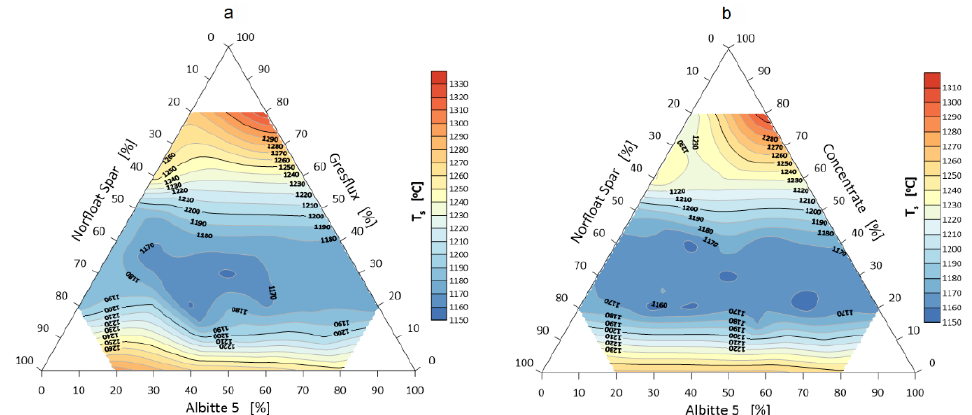
Figure 3. Shrinkage onset temperature T g of the flux system: Greflux–Albitte 5–Norfloat Spar ( a ), and Concentrate–Albitte 5–Norfloat ( b ).